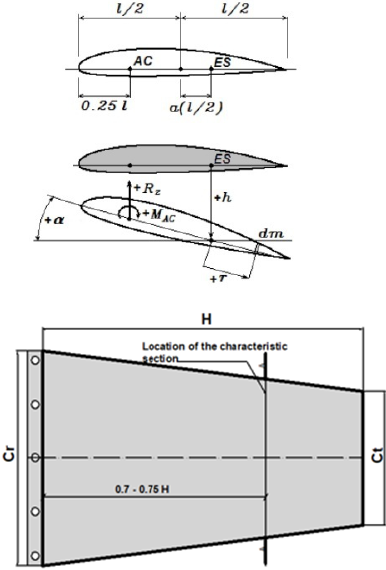
Figure 1. A typical section is located at 0.75 % of the lifting surface span.